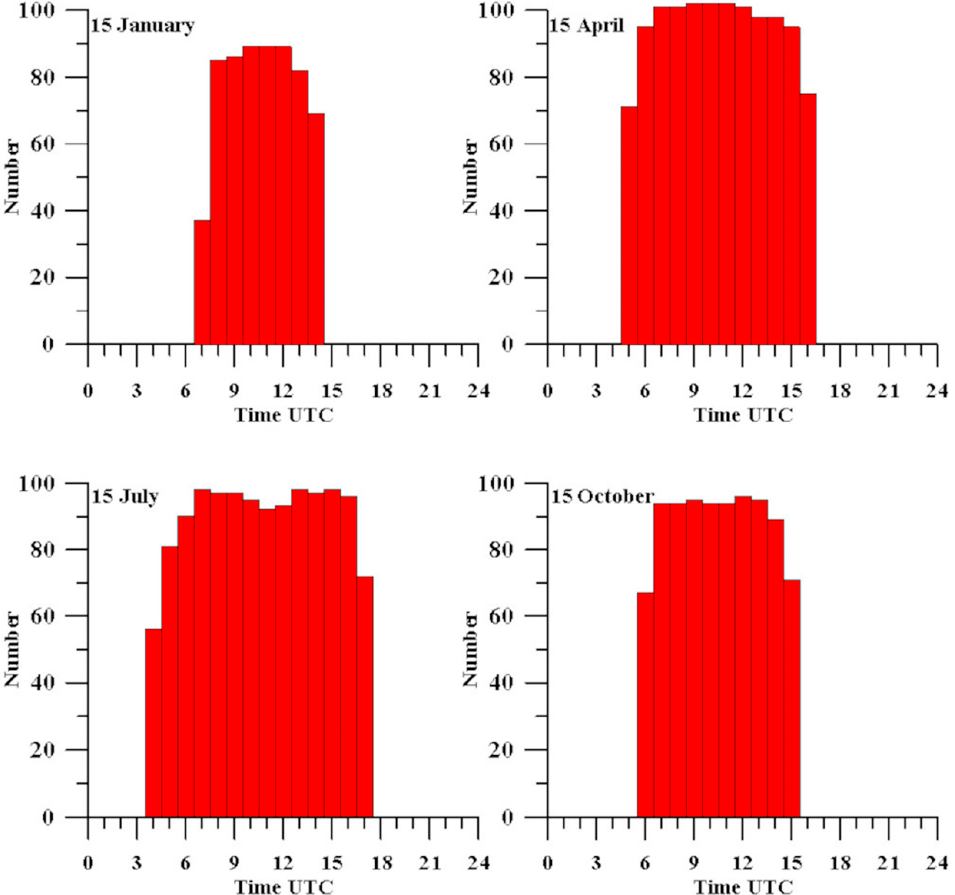
Figure 2. Number of valid UV-Index values for each hour of the day for four days of the year (15 January ( upper left ), 15 April ( upper right ), 15 July ( lower left ), 15 October ( lower right )) during winter, spring, summer and autumn seasons.